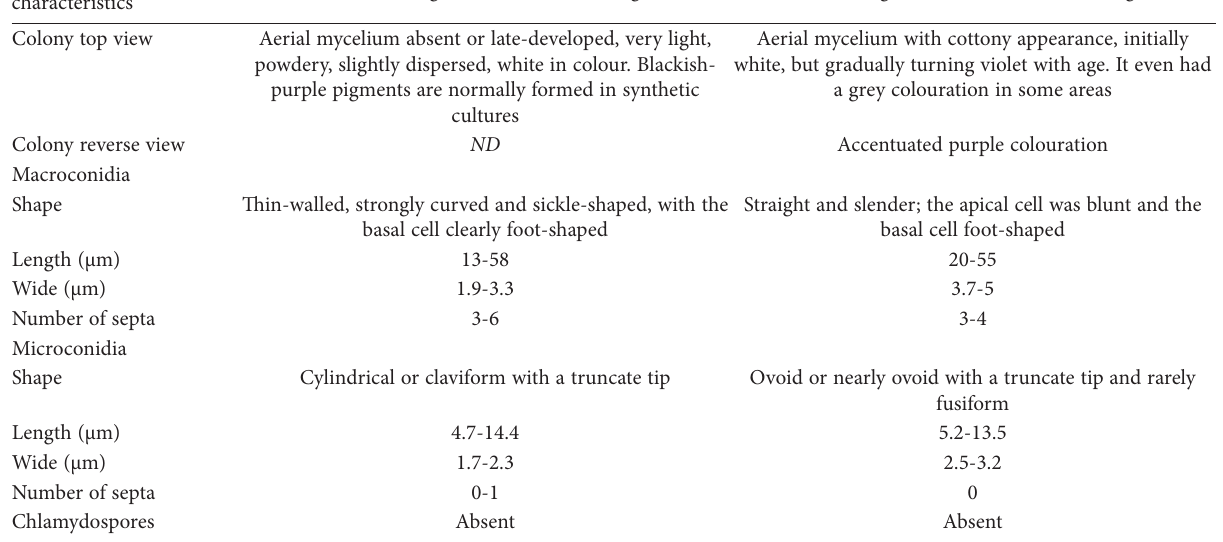
Table 2. Morphological characteristics of Fusarium annulatum isolate MLFR-09, causing fruit rot in cantaloupes, compared with previous descriptions of F. annulatum by Bugnicourt (1952), Nelson et al . (1983), and Yilmaz et al . (2021). Morphological